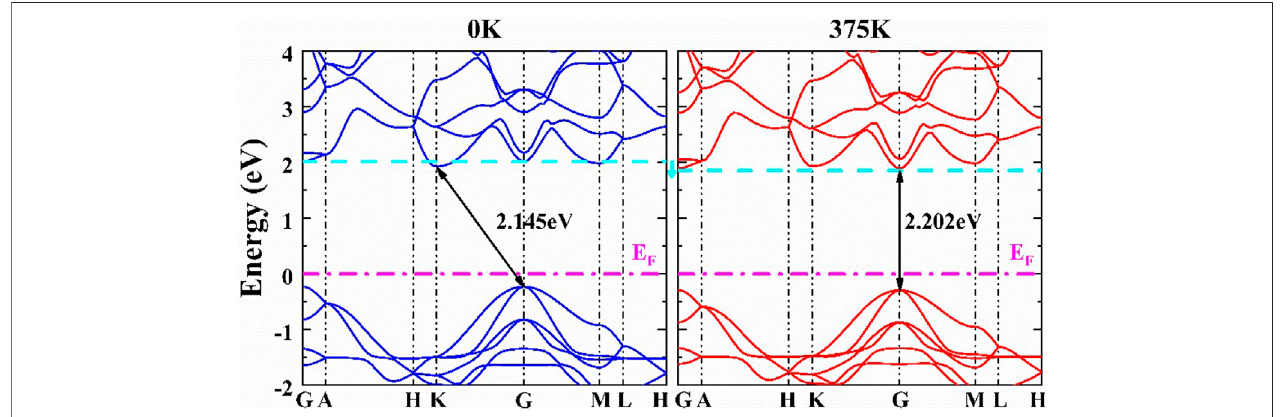
FIGURE8| Electronic structures ofthe β -CuSCN atdifferentvolumes(the correspondingtemperatures 0and375 K werelabeled). Thecyandashed lines indicate the lowest unoccupied levels at the G point.